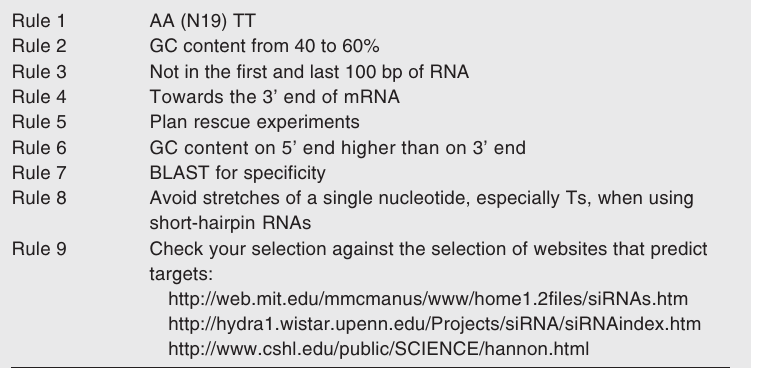
Table 2. Some rules for a successful sequence